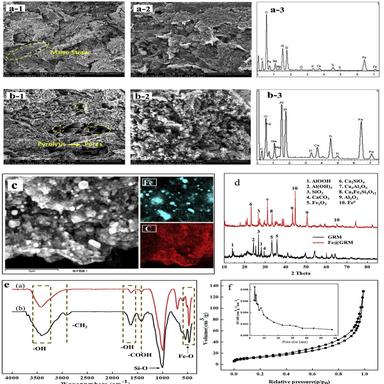
Scanning electron microscopic (SEM) image of GRM (a-1, 1000x; a-2, 10,000x) and Fe@GRM (b-1, 1000x; b-2, 10,000x); EDS image of GRM (a-3) and Fe@GRM (b-3); Elemental mapping images of Fe@GRM (c); X-Ray diffraction (XRD) pattern of GRM and Fe@GRM (d); Fourier transform infrared (FTIR) spectra of GRM (e-a) and Fe@GRM (e-b); Pore size distribution of Fe@GRM (f).